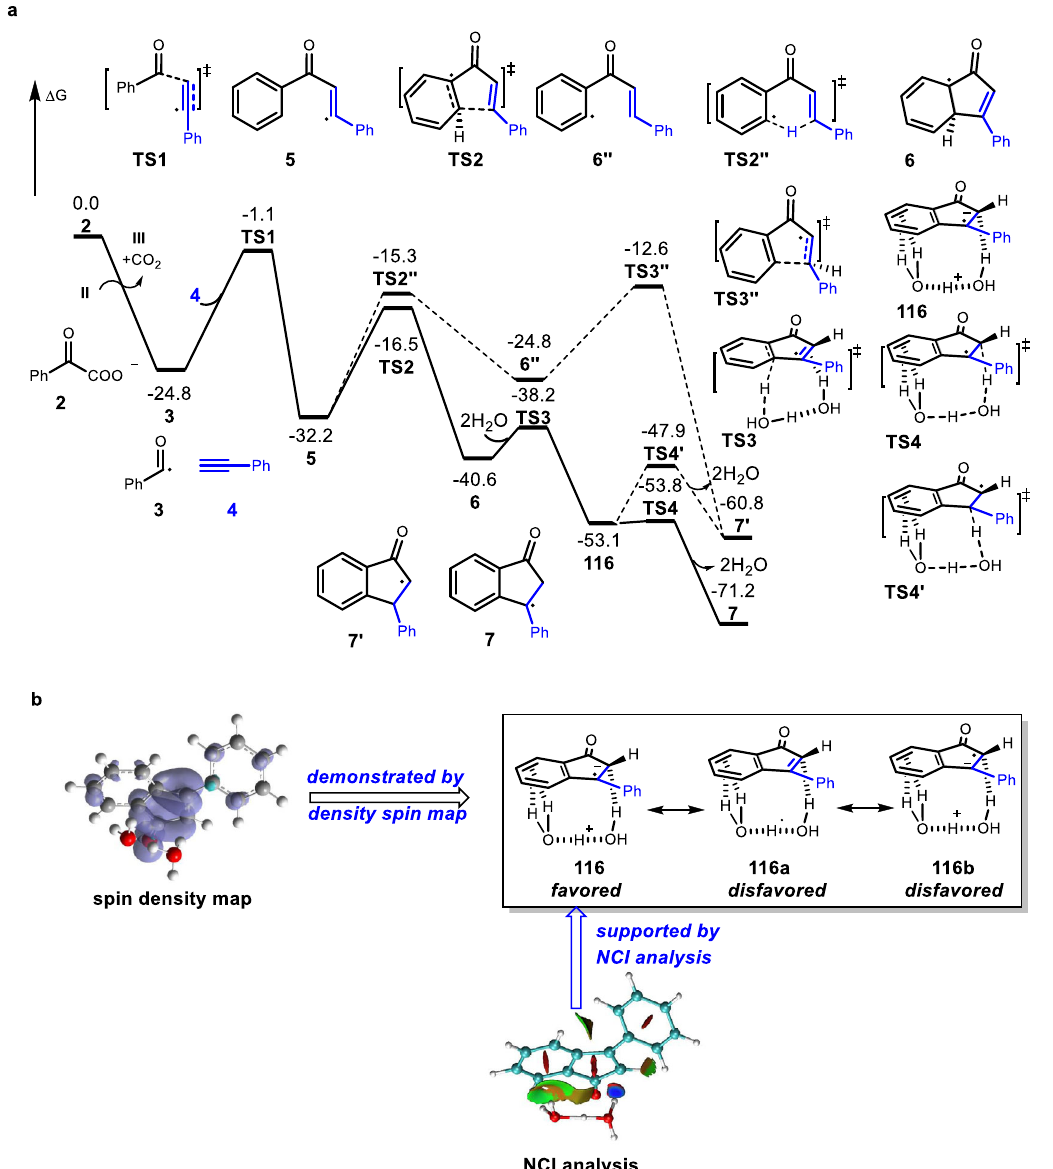
Fig. 9 The free energy barrier for the reaction and the spin density and noncovalent interaction (NCI) analysis for the intermediate 116. a Computational studies. b The spin density map and NCI analysis for the intermediate 116